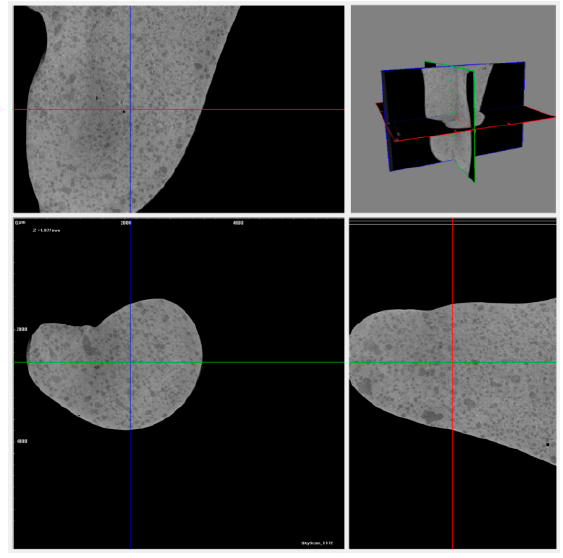
Figure 16. Three-axes slice for the GdAB-based composite.